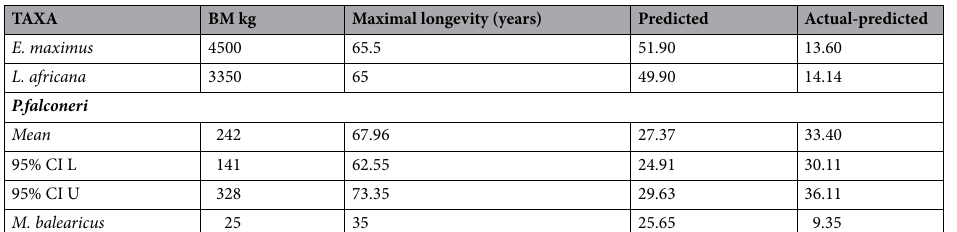
Table 3. Predicted and residual values for maximal longevity against body mass in extant proboscideans, P. falconeri and one ungulate insular taxon, Myotragus balearicus 36 . Results of PGLS longevity for extant ungulates (n = 155; data from AnAge data base 35 ) are: Y = a + bx, Intercept (a) 1.21941, slope (b) 0.135772, Residual standard error: 0.01342 on 153 degrees of freedom, Multiple R-squared: 0.3746, Adjusted R-squared: 0.3706, F-statistic: 91.66 on 1 and 153 DF, p -value: < 2.2e–16. The values of P. falconeri are the mean lifespan and the 95% CI, for the BM of P. falconeri L: lower bound, U: upper bound (Supplementary material 5, 8, Supplementary Figs. 12, 13).